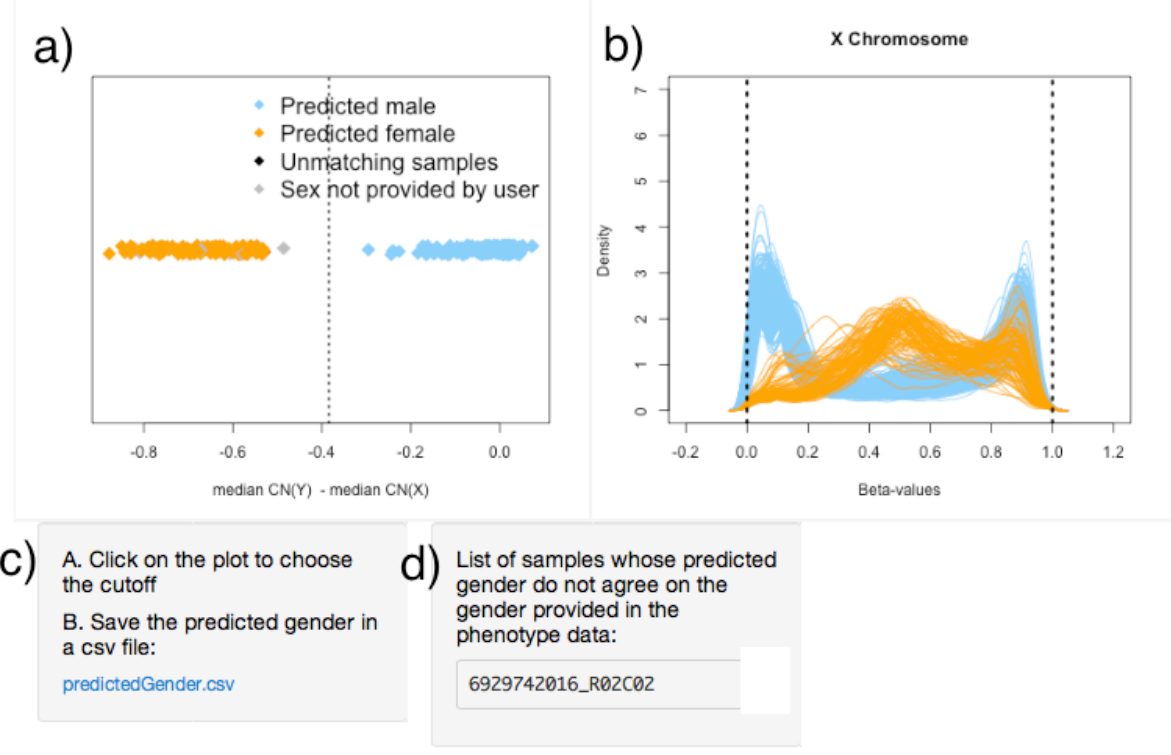
Figure 4. Sex prediction interface. The difference of the median copy number intensity for the Y chromosome and the median copy number intensity for the X chromosome can be used to separate males and females. In a ), the user can select the vertical cutoff (dashed line) manually with the mouse to separate the two clusters (orange for females, blue for males). Corresponding Beta-value densities appear in b ) for further validation. The predicted sex can be downloaded in a csv file in c ), and samples for which the predicted sex differs from the sex provided in the phenotype will appear in d